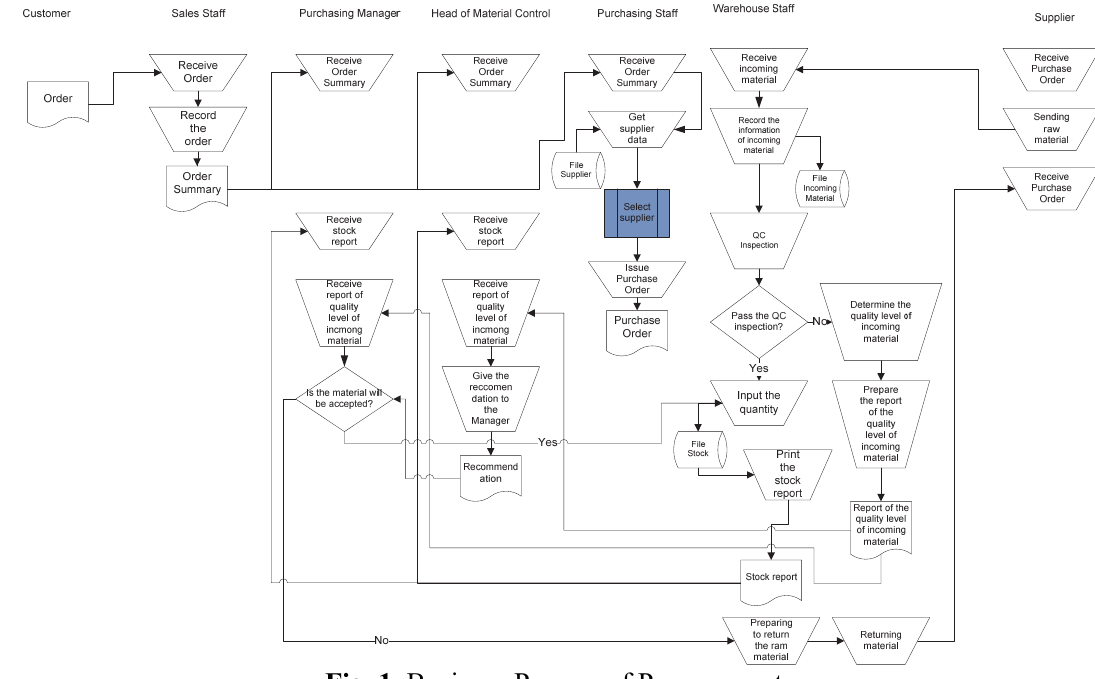
Fig. 1. Business Process of